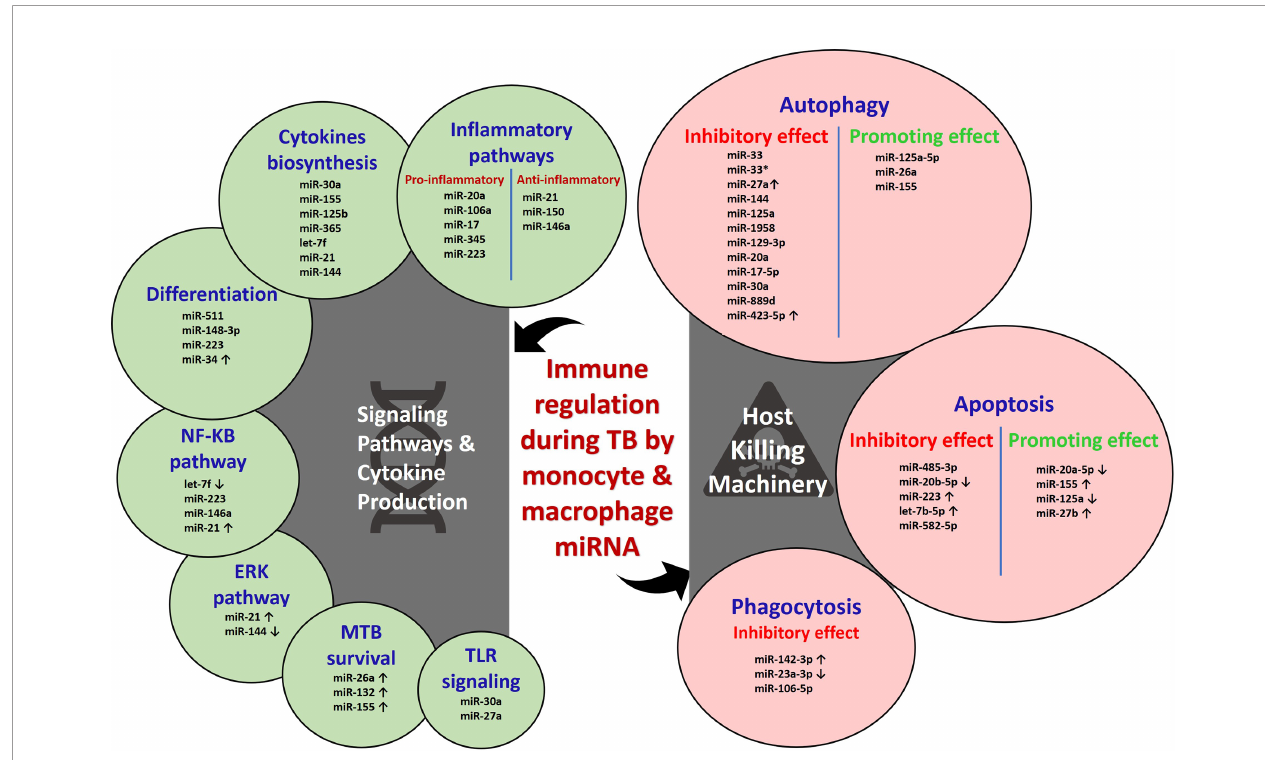
FIGURE 1 | Host immune regulation by monocyte and macrophage miRNAs during